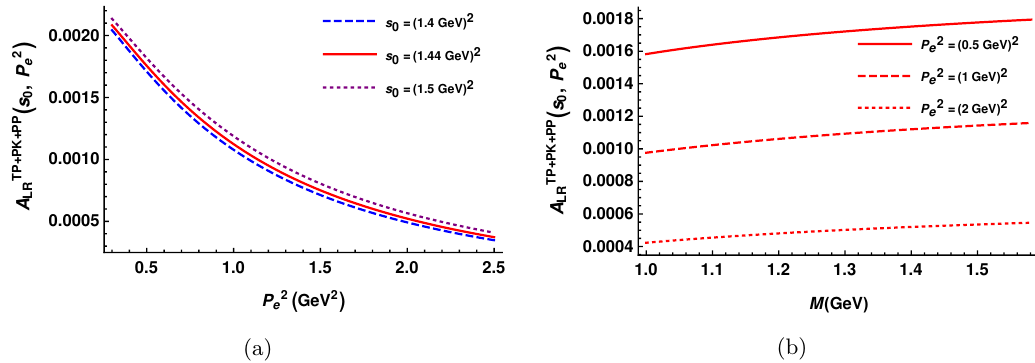
) is calculated from the combination of F TP , F PK and Figure 3 . The physical FF, A LR ( s 0 , P 2 e LR LR employing photon DAs. Left panel: A TP + PK + PP ( s ) vs P 2 is shown for three values of 2 F PP 0 , P e e LR LR s 0 = (1 . 4 GeV ) 2 (violate dotted), s 0 = (1 . 44 GeV ) 2 (red solid) and s 0 = (1 . 5 GeV ) 2 (blue dashed) at the Borel Mass, M 2 = 2 GeV 2 . Right Panel: A TP + PK + PP ( s ) vs M is shown for three 2 0 , P e LR values of P 2 = 0 . 5 GeV 2 (red solid), P 2 = 1 GeV 2 (red dashed) and P 2 = 2 GeV 2 (red dotted) at e e e the continuum threshold, s = (1 . 44 GeV ) 2 . 0